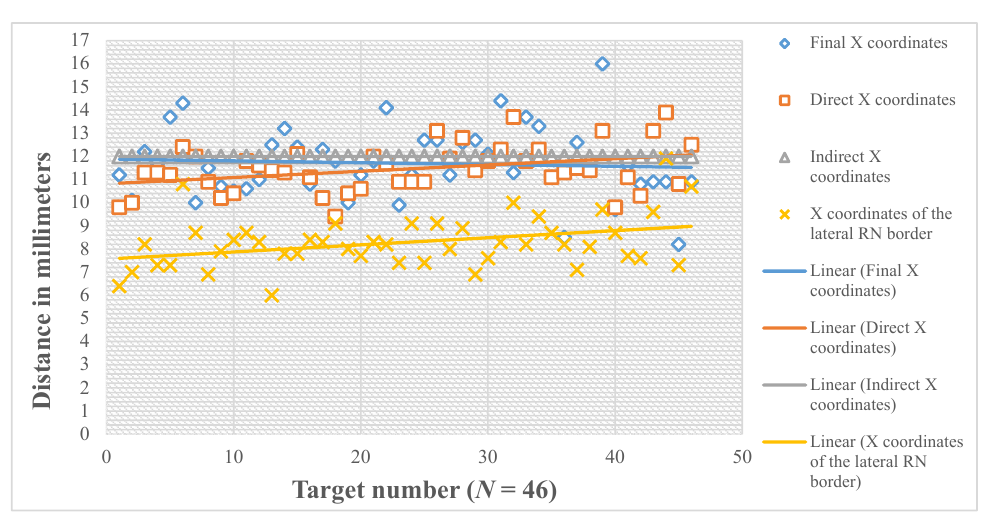
Figure 11. The X coordinates in relation to the mid-commissural point (MCP). Table 1. The differences between the direct and indirect coordinates of STN from the final active electrode coordinates.